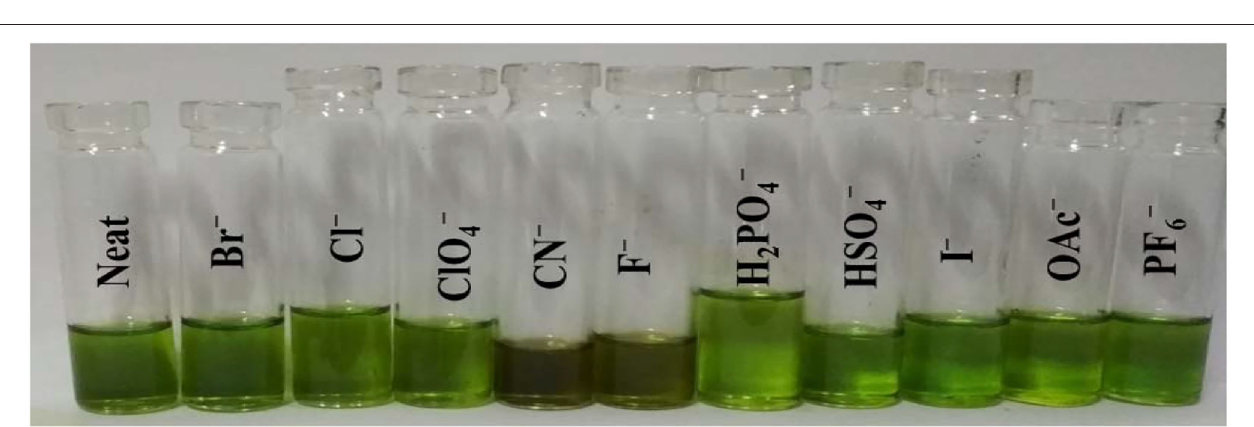
a protonating agent and also dissolves CN − and F − ions (from their